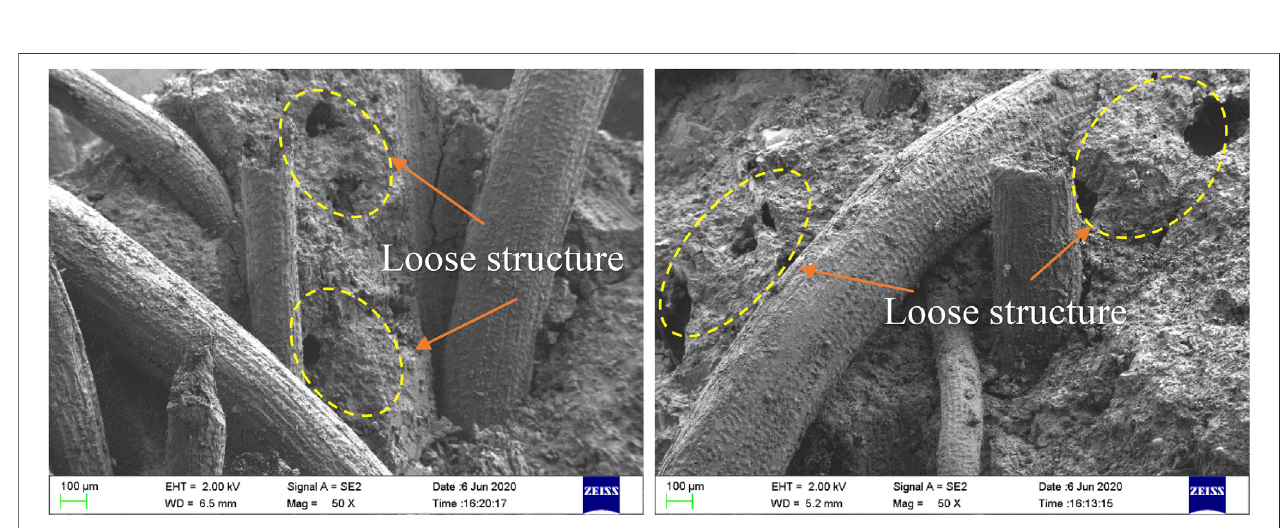
FIGURE 9 | Boundary of coconut fi ber and MPC (A) interface between CF and MPC; (B) rough surface of CF.